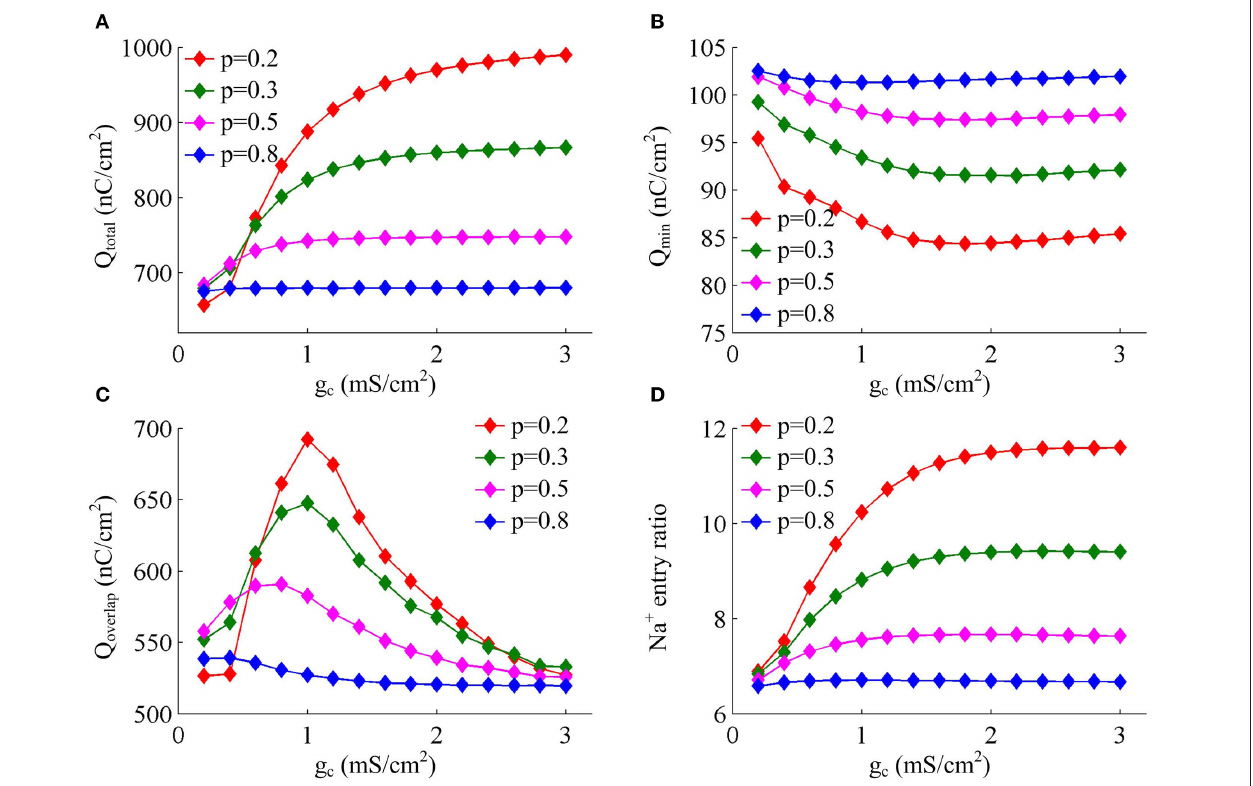
FIGURE 4 | Increasing coupling conductance between chambers reduces AP efficiency in model I. (A) Total Na + load Q total , (B) minimal Na + load Q min , (C) overlap Na + load Q overlap , and (D) Na + entry ratio are respectively plotted as a function of g c in model I. The value of p is 0.2, 0.3, 0.5, and 0.8. Dendritic input is 2 µ A / cm 2 . Since applied I D alters the final output of model I neuron, the items for an AP examined here are different from those with same p and g c in Figures 1D–F